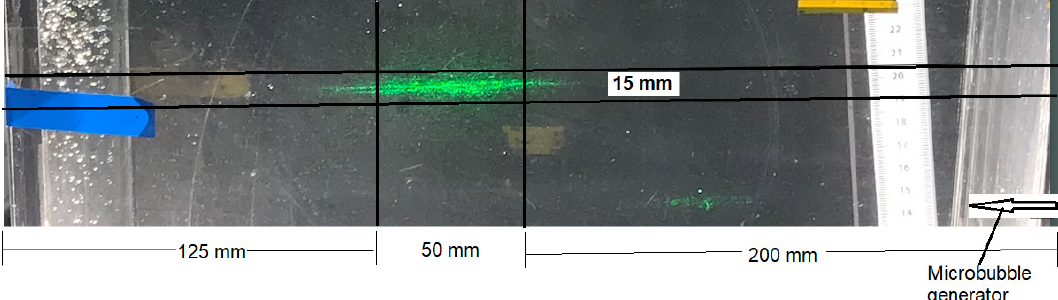
Figure 2. The front view of the water tank to show the locations of microbubble generator and the location of the images collected in the water tank.